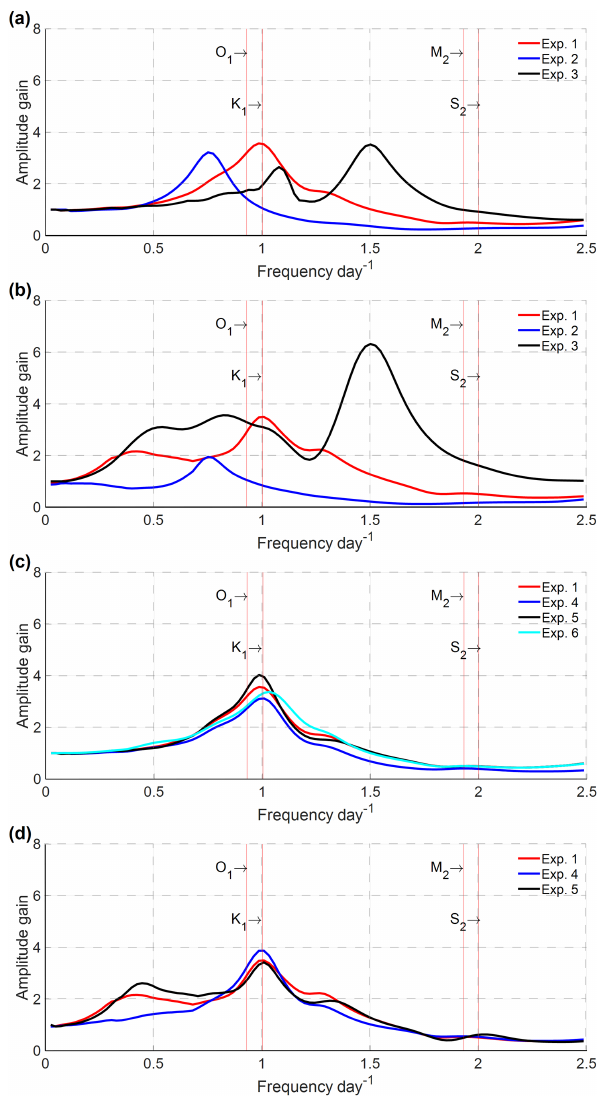
Figure 3. Response functions (amplitude gains as a function of fre- quency) of the South China Sea body (SCSB) (a) and the Gulf of Thailand (GOT) (b) for different bottom topographies of the SCSB, and response functions of the SCSB (c) and the GOT (d) for dif- ferent topographies in the GOT and closure of the GOT. Here, the amplitude gains refer to the area means of the top 20% values. The definition of the experiments is given in Table 2.